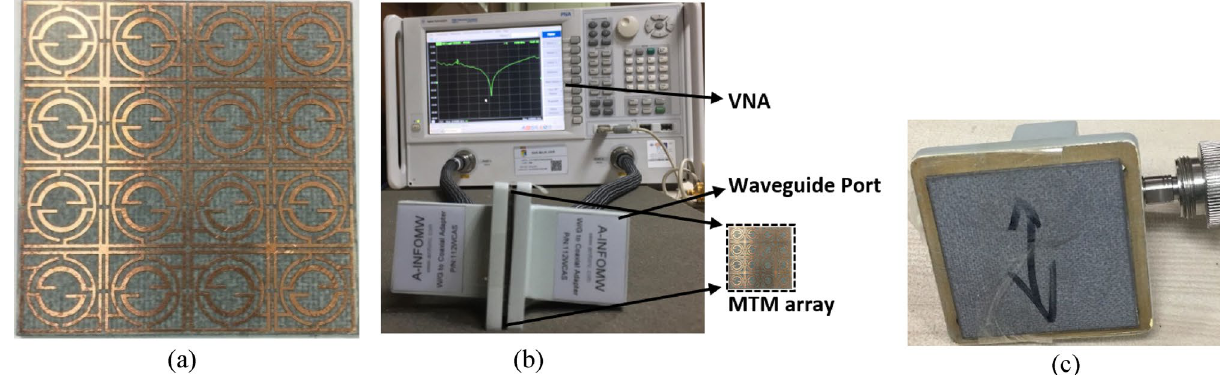
Figure 13. ( a ) Fabricated prototype of 2 × 2 array of proposed MTM unit cells. ( b ) Experimental setup to determine S 21 using VNA and waveguide port, ( c ) placement of MTM array with the waveguide